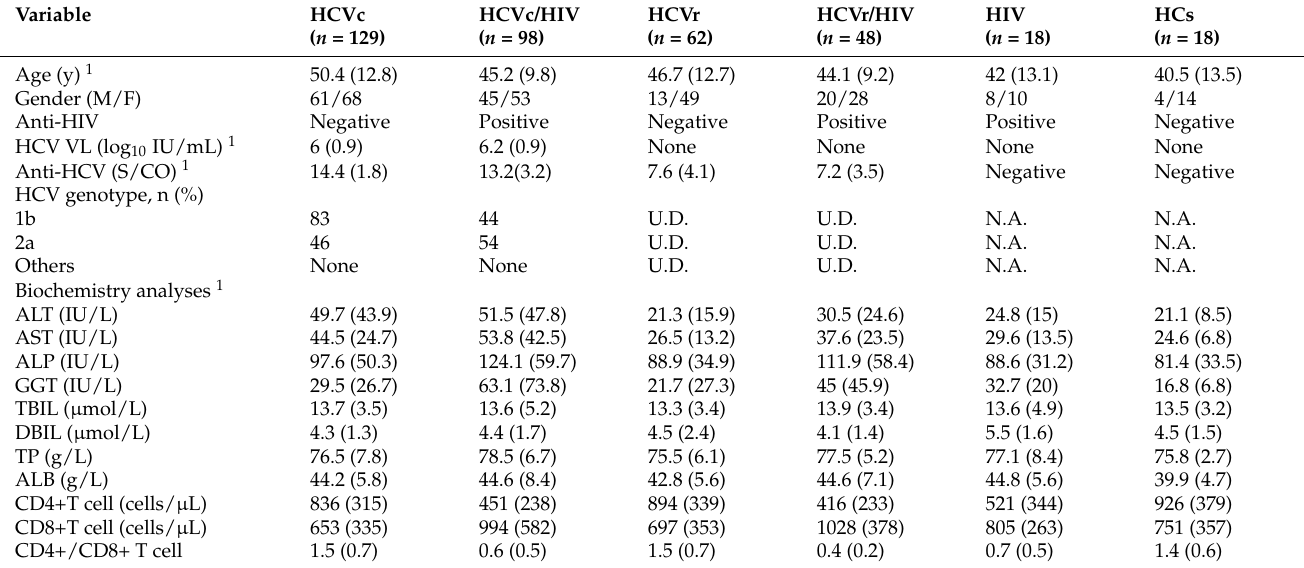
Table 1. The demographic and clinical characteristics of all individuals enrolled in the study in 2009. Variable